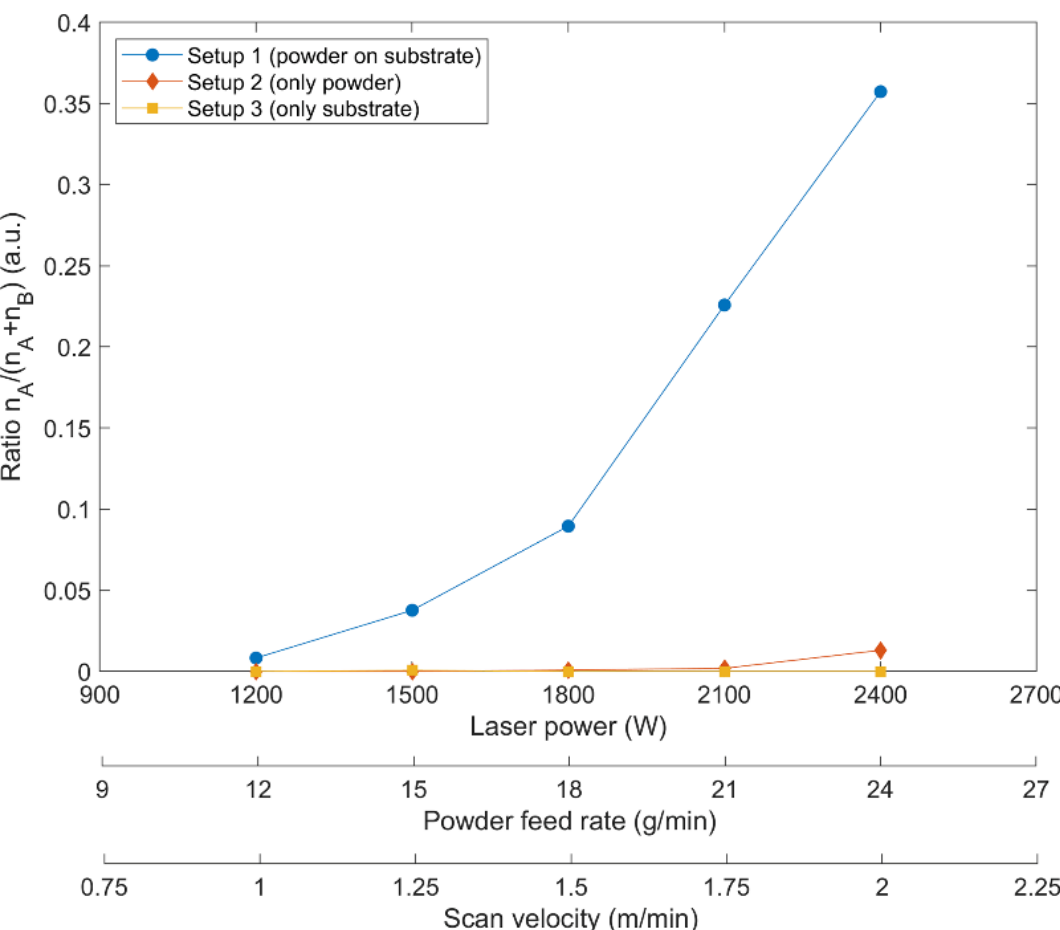
Figure 9. Incidence of detected type A spectra for setups 1–3 vs. laser power, powder feed rate, and scan velocity,